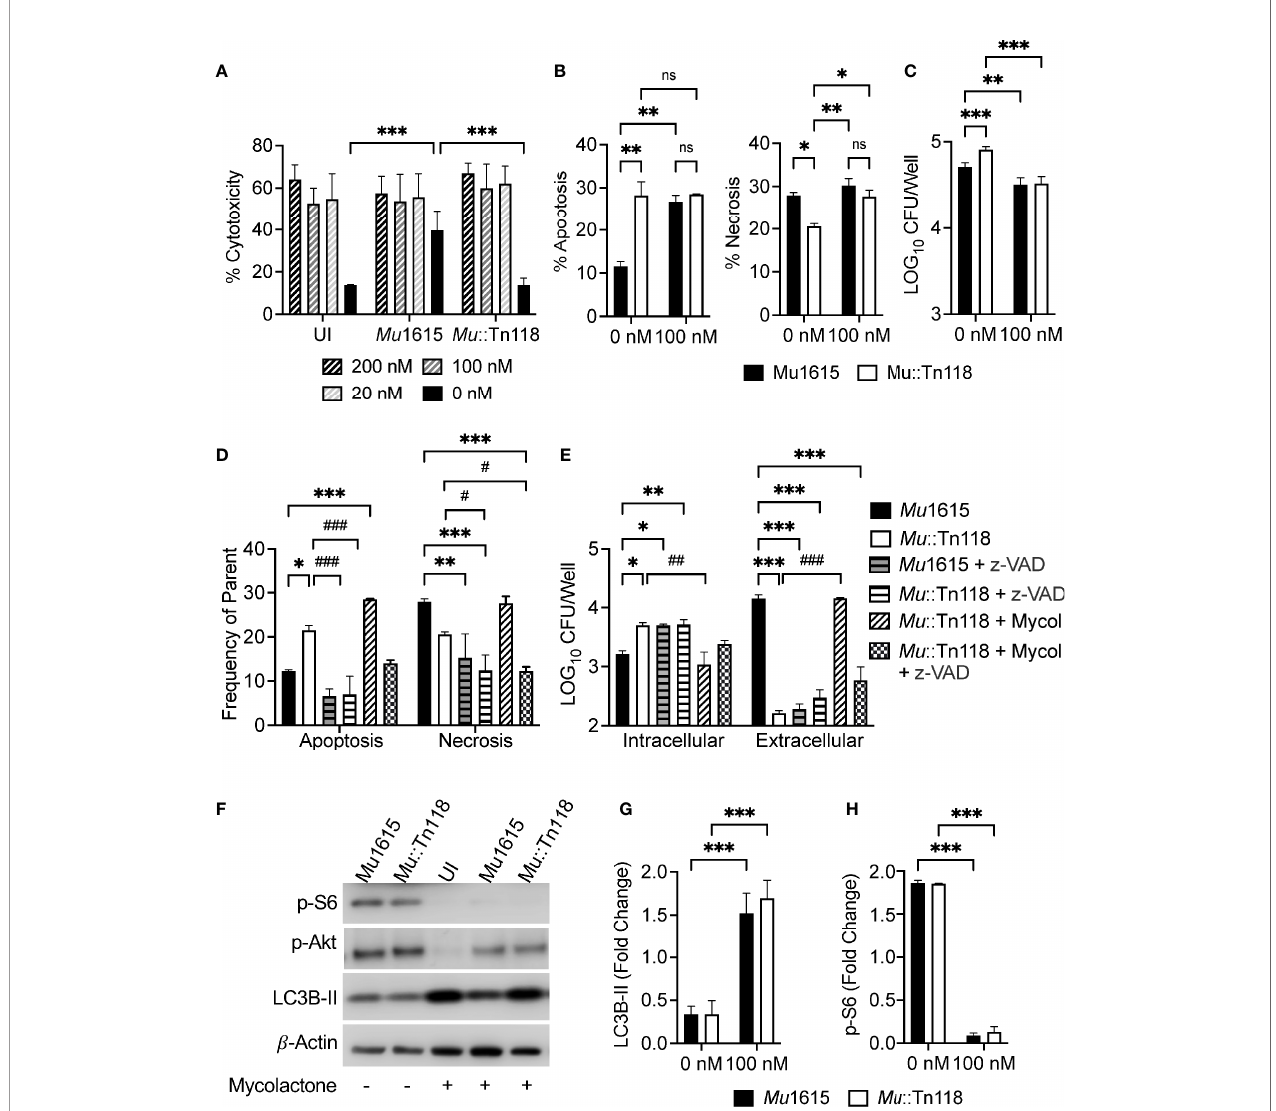
FIGURE 3 | Synthetic mycolactone induces apoptosis, necrosis, and autophagy during Mul infection. (A) THP-1 monocyte-derived macrophages infected with Mu 1615 or Mu ::Tn118 at MOI 10 were treated with 200, 100, 20, and 0 nM of synthetic mycolactone. At 72 h postinfection, LDH release was measured. (B) Apoptosis and necrosis were assayed by staining with Annexin-V and 7-AAD in THP-1 monocyte-derived macrophages infected with Mu 1615 or Mu ::Tn118 at MOI 10 ± 100 nM mycolactone, 72 h postinfection. (C) THP-1 monocyte-derived macrophage cell lysates were plated for CFU enumeration at 72 h postinfection with Mu 1615 and Mu ::Tn118 at MOI 10 ± 100 nM mycolactone treatment. (D) THP-1 monocyte-derived macrophages infected with Mu 1615 or Mu ::Tn118 at MOI 10 were treated with pan-caspase inhibitor, Z-VAD-FMK (z-VAD), or 100 nM synthetic mycolactone (Mycol). At 72 h postinfection, apoptosis and necrosis were assayed by staining with Annexin-V and 7-AAD. * and # indicate the comparison with Mu 1615 or Mu ::Tn118, respectively. (E) THP-1 monocyte-derived macrophage culture supernatant and cell lysate were plated for CFU enumeration at 72 h postinfection with Mu 1615 and Mu ::Tn118 at MOI 10 with and without treatment of z- VAD or 100 nM Mycolactone. (F) Immunoblots were assayed from lysates of THP-1 monocyte-derived macrophages infected with Mu 1615 or Mu ::Tn118 at MOI 10 ± 100 nM mycolactone treatment, 72 h post-infection for LC3B-II, p-Akt, or p-S6. (G, H) Summary densitometric analysis was calculated by LC3B-II or p-S6 normalized to b -actin. All graphs represent one of two independent experiments with data expressed as mean ± SD. Signi fi cance was calculated by two-way ANOVA corrected by Dunnett ’ s test for multiple comparisons. ns, not signi fi cant. *p ≤ 0.05, **p ≤ 0.01, *** ≤ p 0.001, # p ≤ 0.05, ## p ≤ 0.01, ### ≤ p